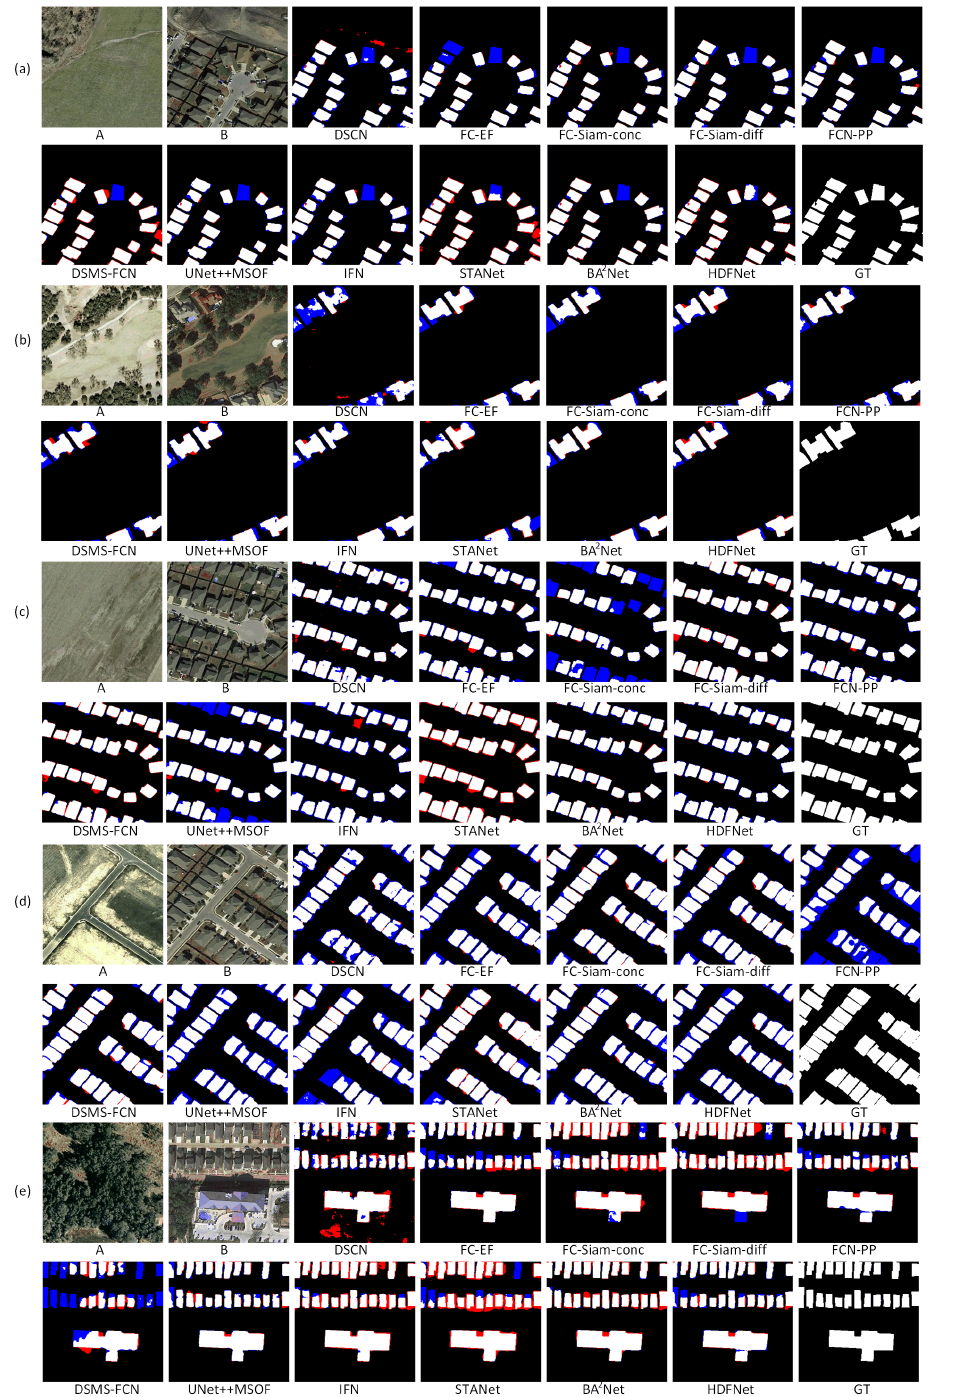
Figure 7. Illustration of qualitative comparison on dataset LEVIR-CD. The ( a – e ) indicate samples from LEVIR-CD and the change maps obtained by different methods.White indicates the changes detected correctly. Black indicates the no change detected correctly. Red indicates the false alarms. Blue indicates unpredicted